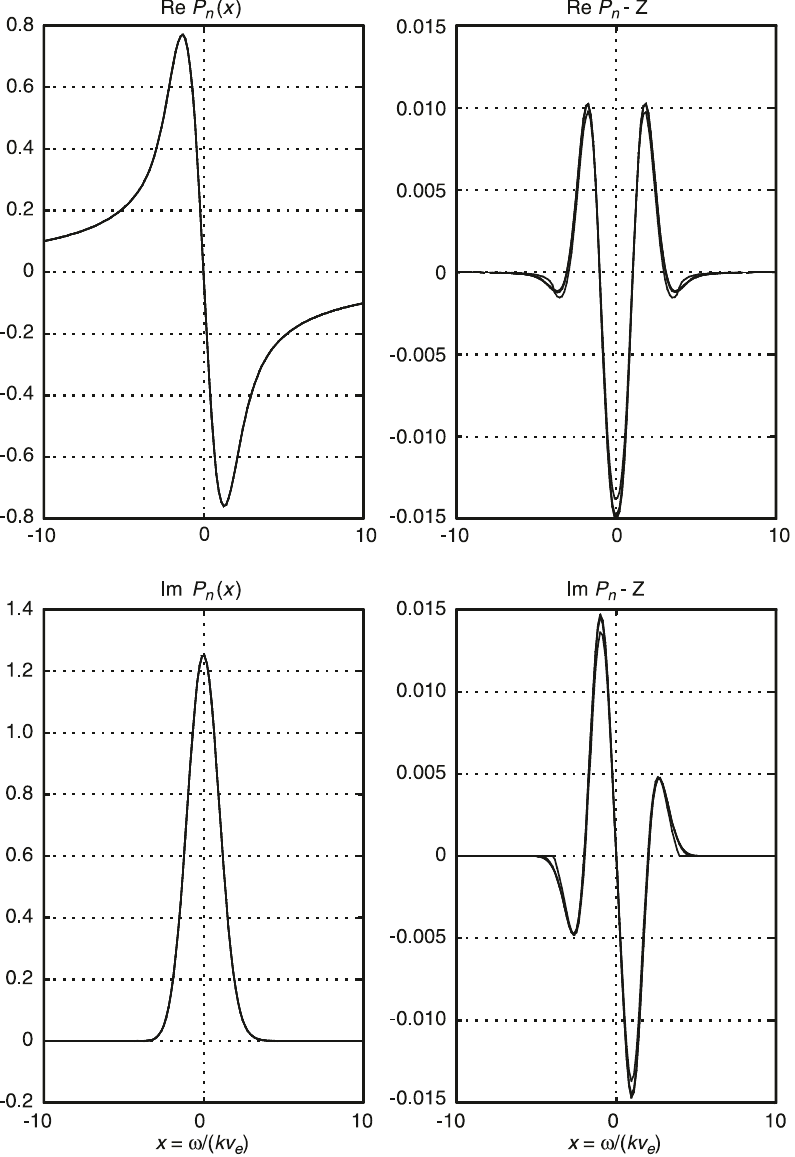
= 4 (cid:99) . On T E